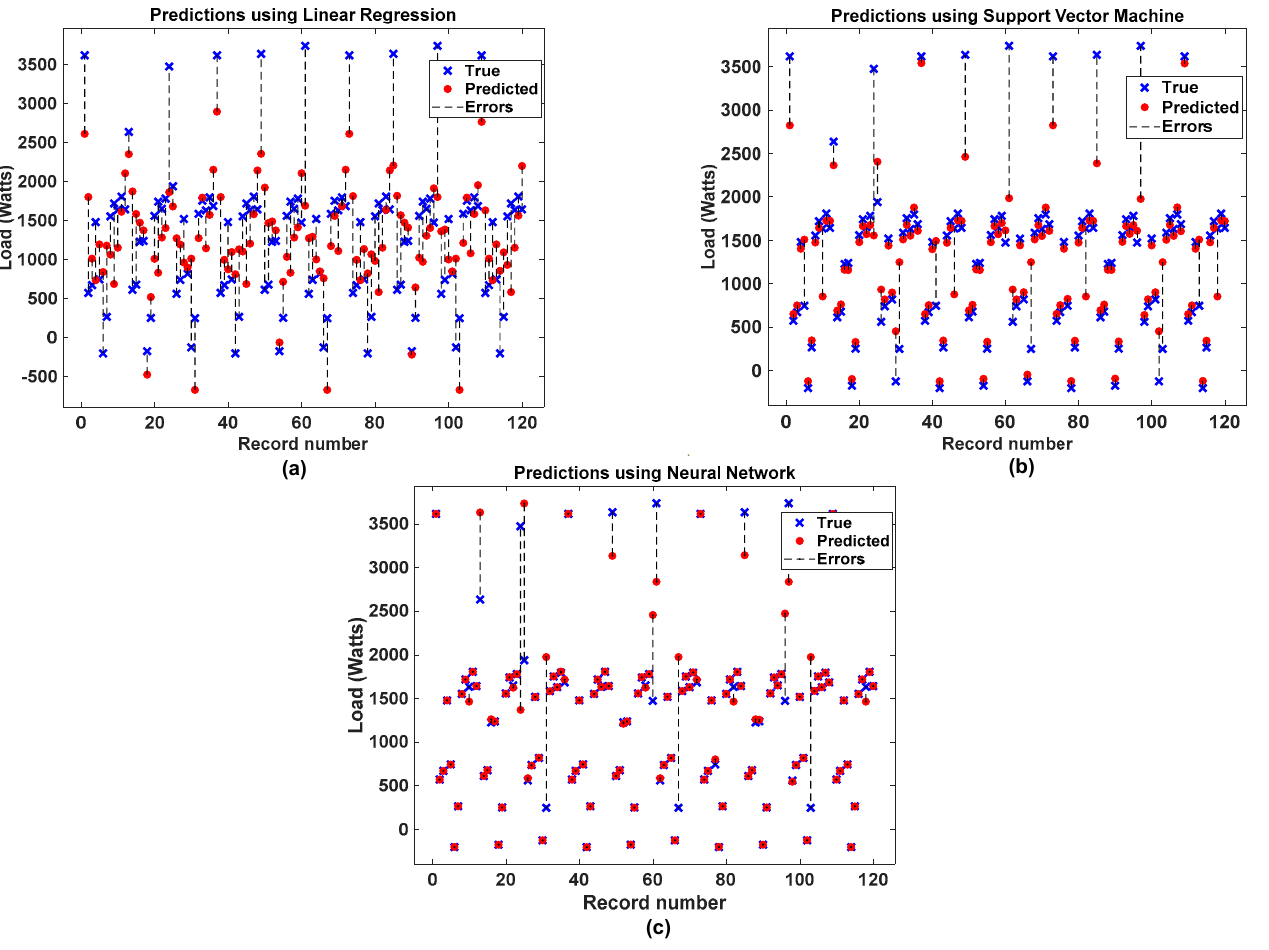
Figure 8. Performance plots showing the accuracy of predicted values with ( a ) Linear Regression (quadratic), ( b ) Support Vector Machine, and ( c ) Artificial Neural Network models.